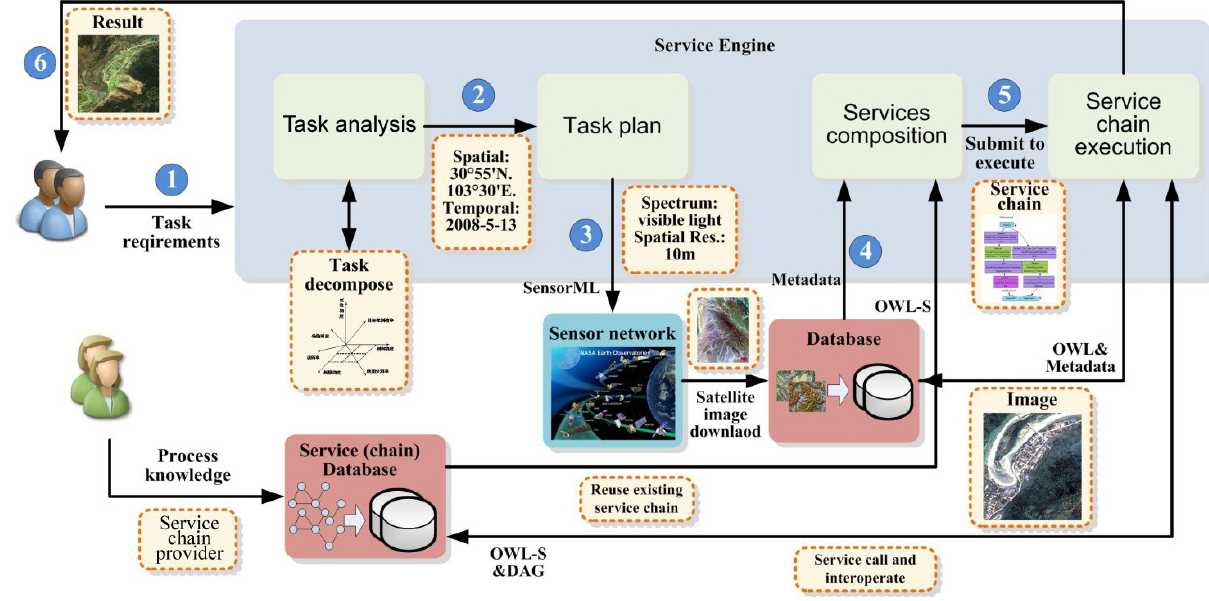
Figure 10. Flowchart of PGIS on finding damage information in the Wenchuan earthquake.